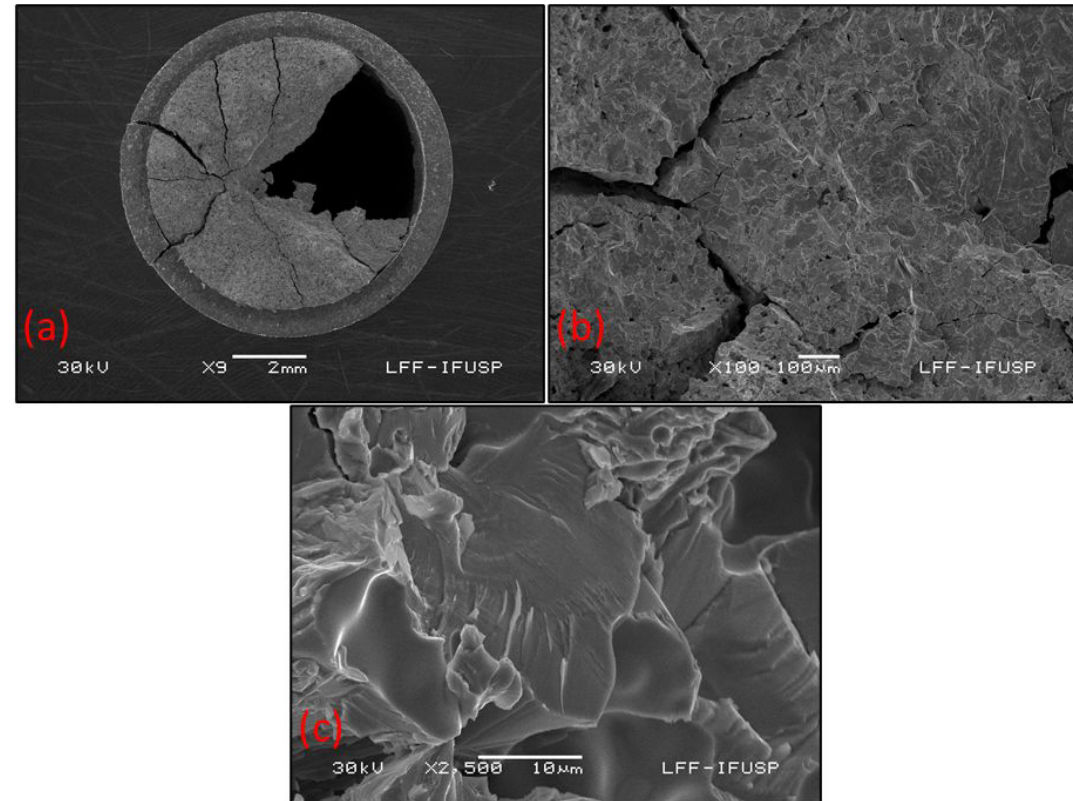
Figure 16. SEM fractography of brazed cathode in the (a) overview surface, (b) cracks propagation origin region and (c) grains brittle